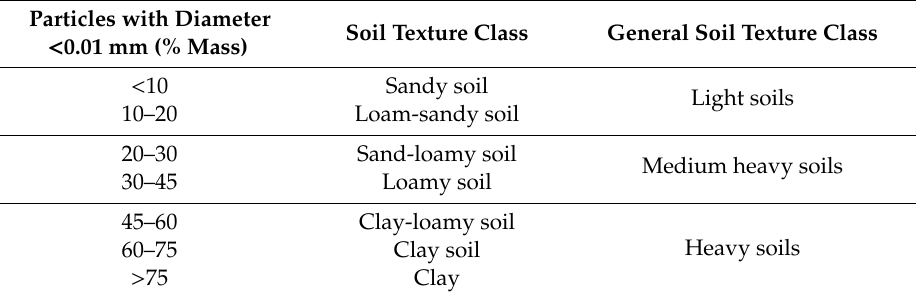
Table 1. Classification of soil texture classes according to Nov á k